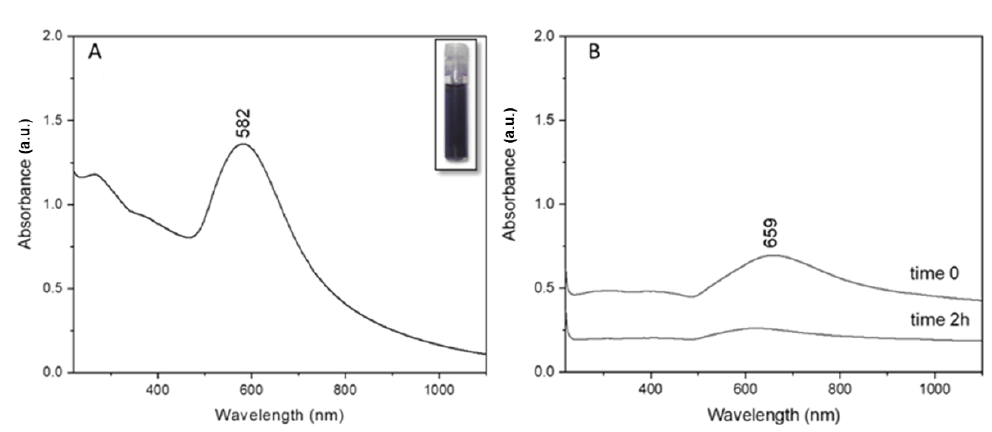
Figure 2. ( A ) UV-Vis spectrum of clg-AuNPs colloid (the inset shows a photo of the colloid in a vial); ( B ) The UV-vis spectra of mixture of gold salt and H 2 O 2 without using any collagen, recorded right after synthesis (time 0) and after 2 h.